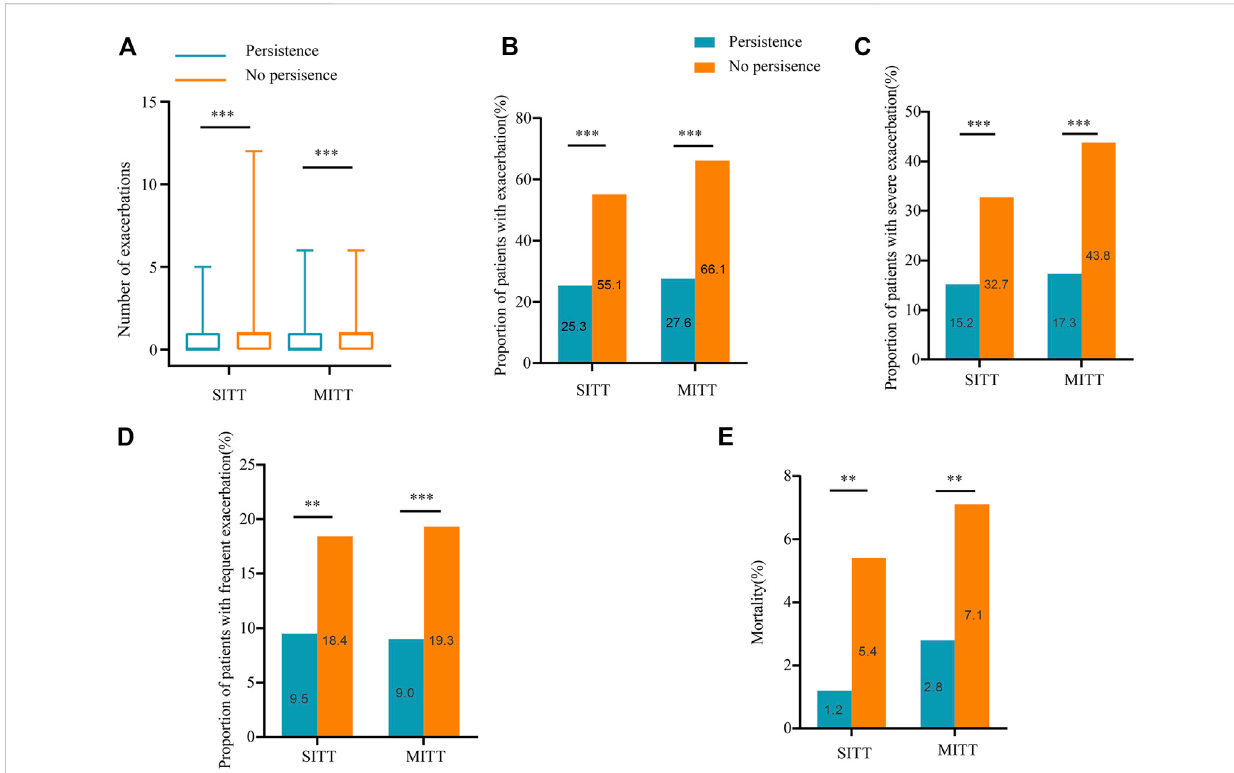
FIGURE 3 Exacerbations and mortality during follow-up according to treatment persistence. (A) Number of exacerbations during 1-year follow-up in patients treated with SITT and MITT according to treatment persistence; (B) proportion of patients with exacerbation during 1-year follow-up in patients treated with SITT and MITT according to treatment persistence; (C) proportion of patients with severe exacerbation during 1-year follow-up in patients treated with SITT and MITT according to treatment persistence; (D) proportion of patients with frequent exacerbation during 1-year follow-up in patients treated with SITT and MITT according to treatment persistence; (E) mortality of patients during 1-year follow-up in patients treated with SITT and MITT according to treatment persistence. MITT, multiple triple-inhaler therapy; SITT, single triple-inhaler